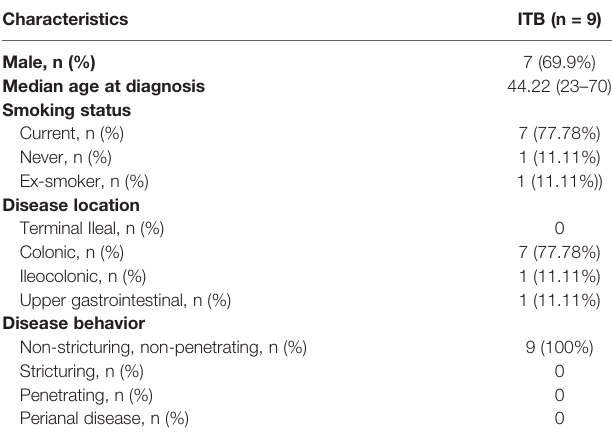
( Figure 1A ). The combination of ASCA IgG and AMCA improved the diagnostic value with an AUC of 0.72, a sensitivity of 65% and a speci fi city of 72.1% ( Figure 1A ). For differentiating CD from ITB, AMCA and Anti-I2 demonstrated the most valuable AUC of 0.712 and 0.691, with the sensitivity of 71.8%and 64.1%, speci fi city of 77.8 and 77.8%, respectively ( Figure 1B ). The cut-off parameters of these two antibodies were 45.5 and 0.419.